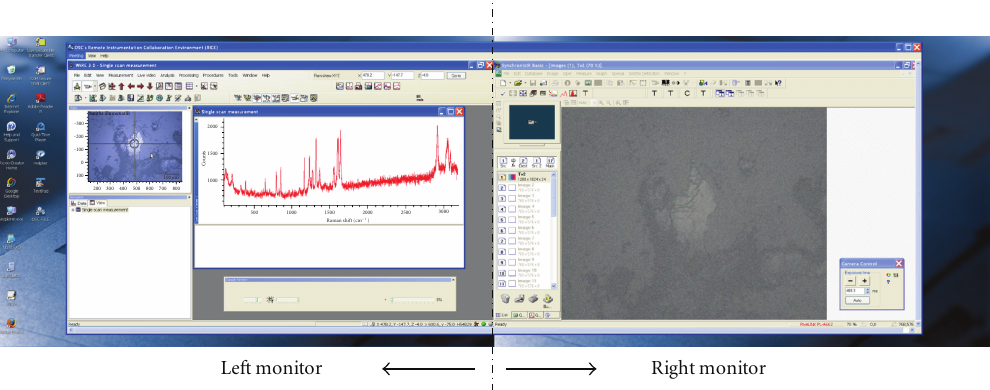
Figure 15: Increased remote dual-screen resolution with